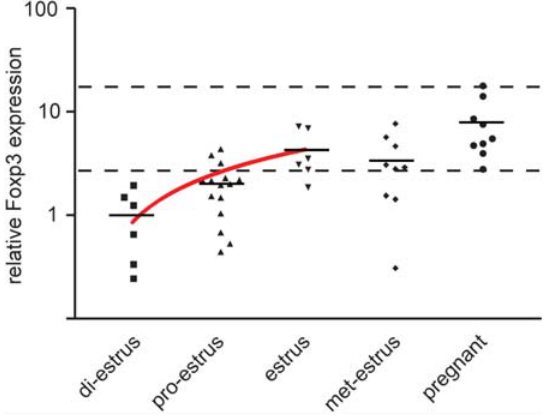
Figure 1. Variation of Foxp3 expression in the uterus during the mouse estrus cycle and pregnancy. Relative levels of Foxp3 were determined by quantitative RT-PCR performed on total uterine mRNA. Uteri were isolated from non-pregnant or pregnant mice at E10.5 (mid- gestation). The estrus cycle phase of non-pregnant mice was de- termined by vaginal smear and mice were categorised into 4 groups, according to their estrus cycle phase. Foxp3 levels for the 4 phases are shown in chronological order and compared to the levels in pregnant mice. Each point corresponds to one animal. Horizontal bars represent the mean of each data set. Dotted lines indicate the maximal and minimal values detected for pregnant mice. The red line indicates the linear trend (linear regression, displayed on logarithmic scale) for the phases approaching estrus. The experiment was performed on 37 non- pregnant and 10 pregnant mice. HPRT mRNA expression levels were used for normalisation. PCR assays were performed in triplicate.